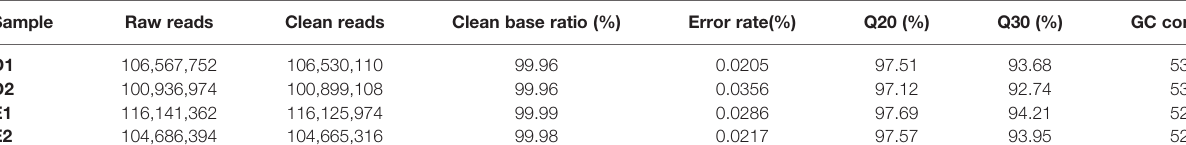
TABLE 3 | Summary statistics of the transcriptome sequencing from group D and group E. Sample